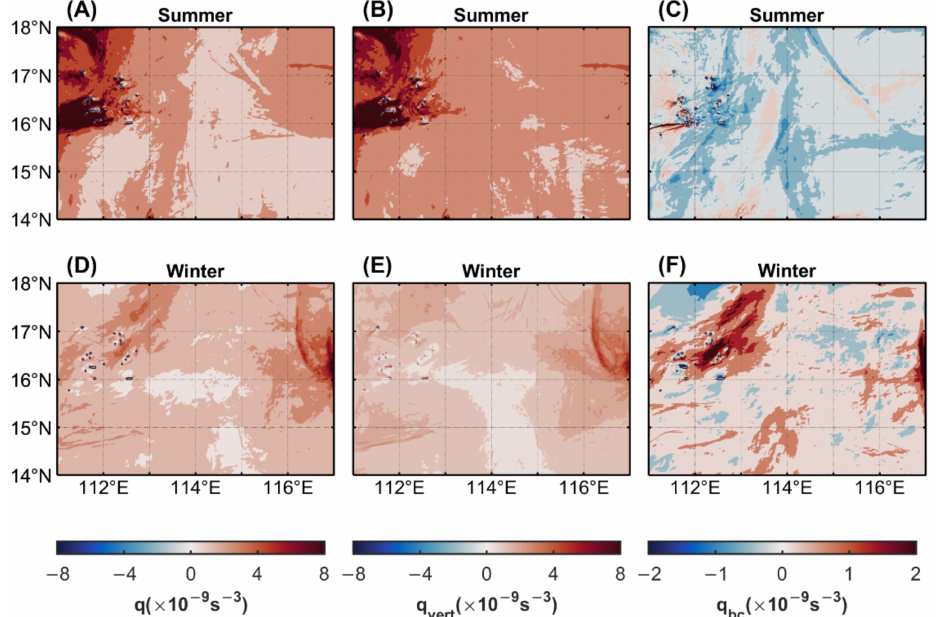
Figure 9. Comparison of the monthly averaged near-surface (at 5 m water depth) Ertel PV q and its sub-components in different cases. The upper row ( A – C ) shows averaged results in July from 2017 to 2019, representing summer. The lower row ( D – F ) shows averaged results in January from 2017 to 2019, representing winter. We note that the color bar in the third column is different from the first and second